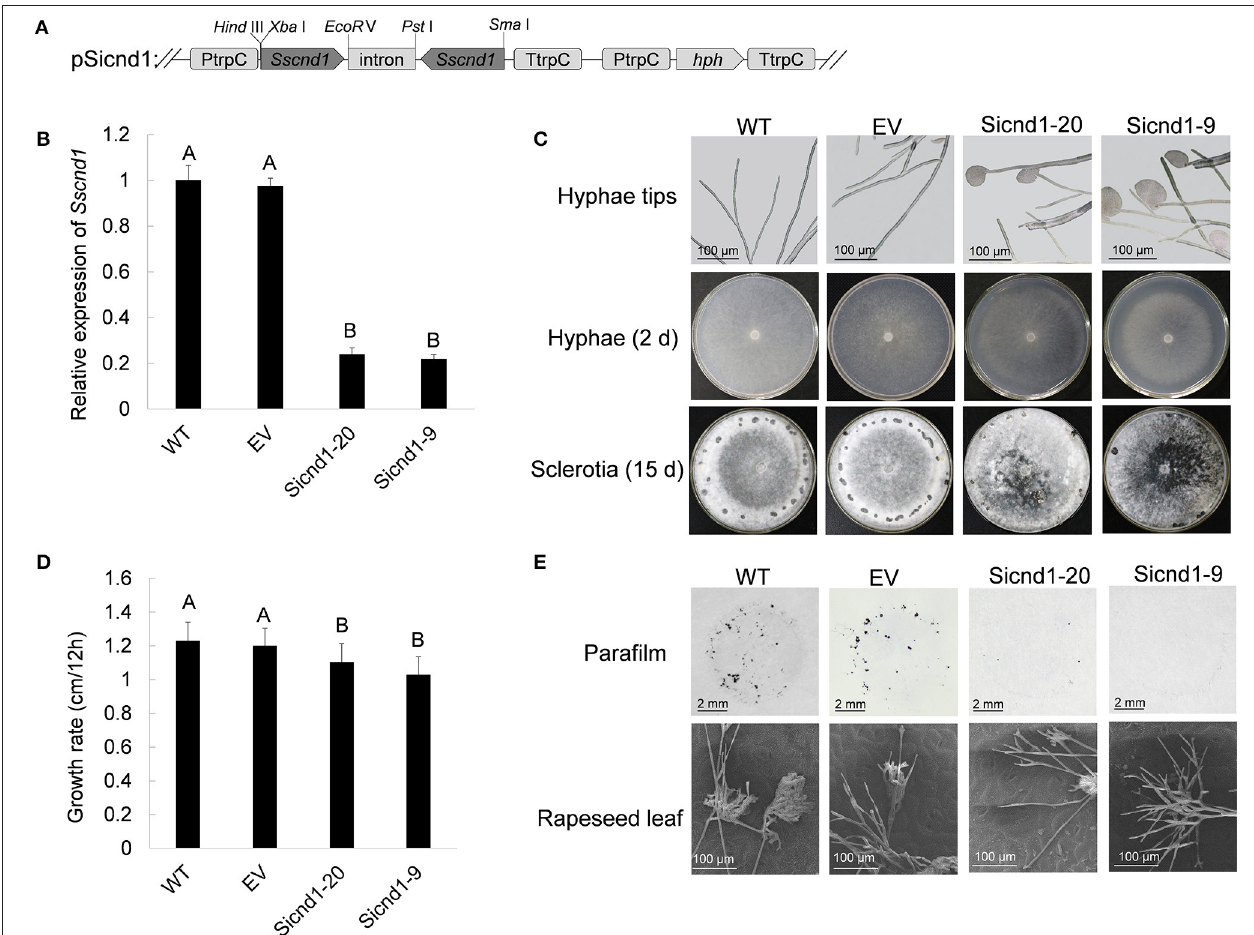
FIGURE 3 | Phenotype of Sscnd1 gene-silenced strains. (A) Construction of the Sscnd1 RNAi vector pSicnd1. (B) Relative expression level of Sscnd1 in different isolates containing pSicnd1, as well as in the wild-type strain (WT) and empty vector strain (EV), as determined by qRT-PCR. The quantity of Sstub1 was used to normalize the expression levels of Sscnd1 in different samples. The relative abundance of Sscnd1 in WT was set as one. Error bars indicate the standard deviation of three independent assays. Differences were assessed using Tukey’s HSD test. Different letters indicate statistical significance at the 0.05 level ( P < 0.05). (C) Phenotypes of the WT, EV, Sicnd1-9, and Sicnd1-20. One representative biological replicate is shown. (D) Radial growth of Sscnd1 gene-silenced strains on PDA. Error bars indicate the standard deviation of three independent assays. Differences were assessed using Tukey’s HSD test. Different letters indicate statistical significance at the 0.05 level ( P < 0.05). (E) Compound appressorium formation of WT, EV, Sicnd1-9, and Sicnd1-20 on parafilm-overlaid PDA (8 hpi [hours post inoculation]) as revealed by the microscope and on rapeseed leaves (8 hpi) as revealed by the scanning electron microscope. One representative biological replicate out of three is